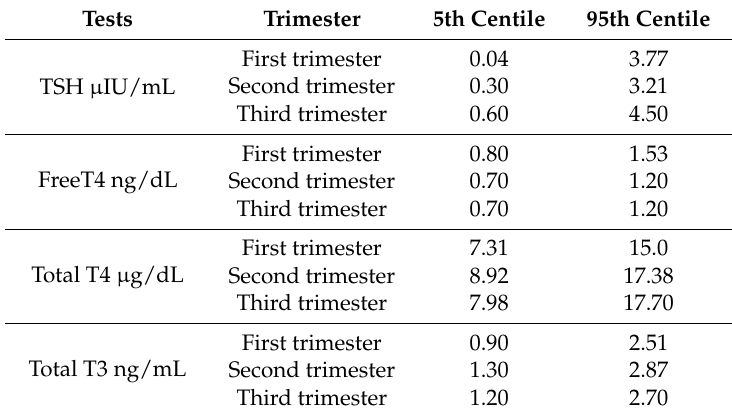
Table 3. The 5th and 95th centile values of thyroid function tests parameters per each trimester.